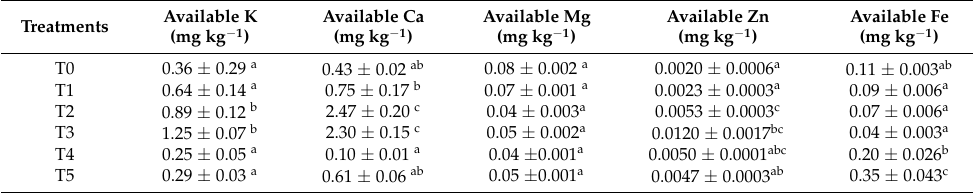
Table 9. Effects of RSRH biochar on available K, Ca, Mg, Zn, and Fe at harvest (70 DAT).